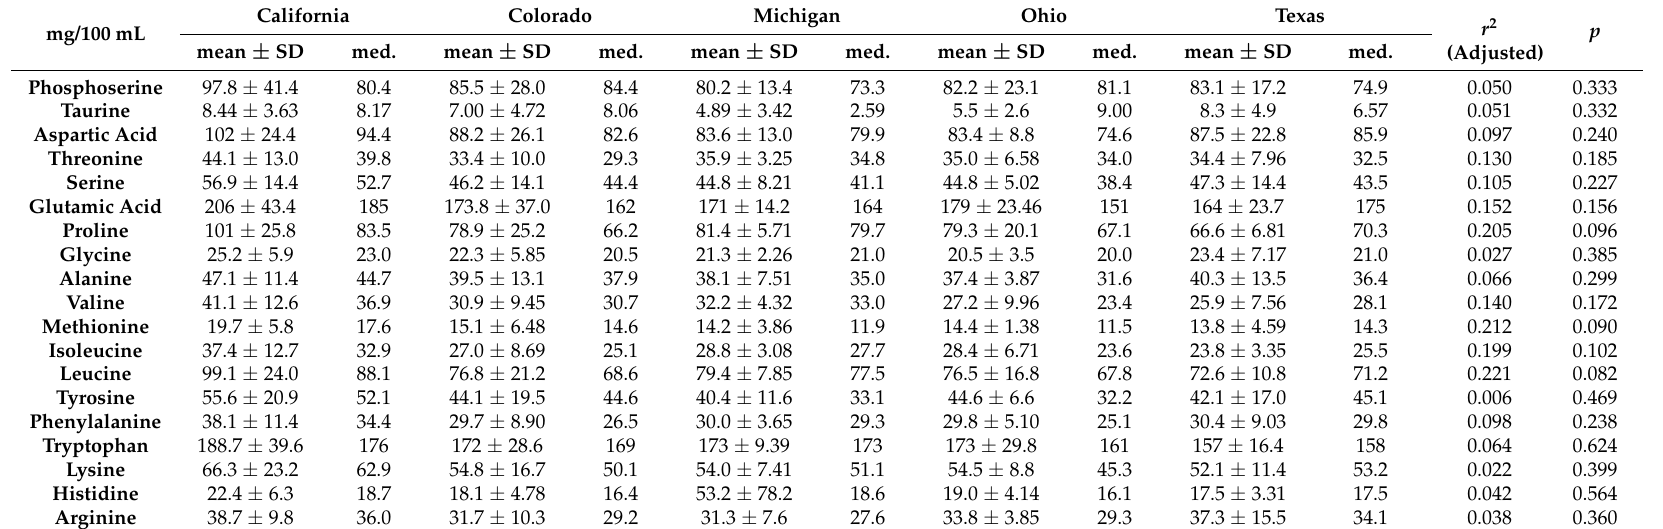
Table 3. Amino acid levels in pooled samples obtained from Regional Milk